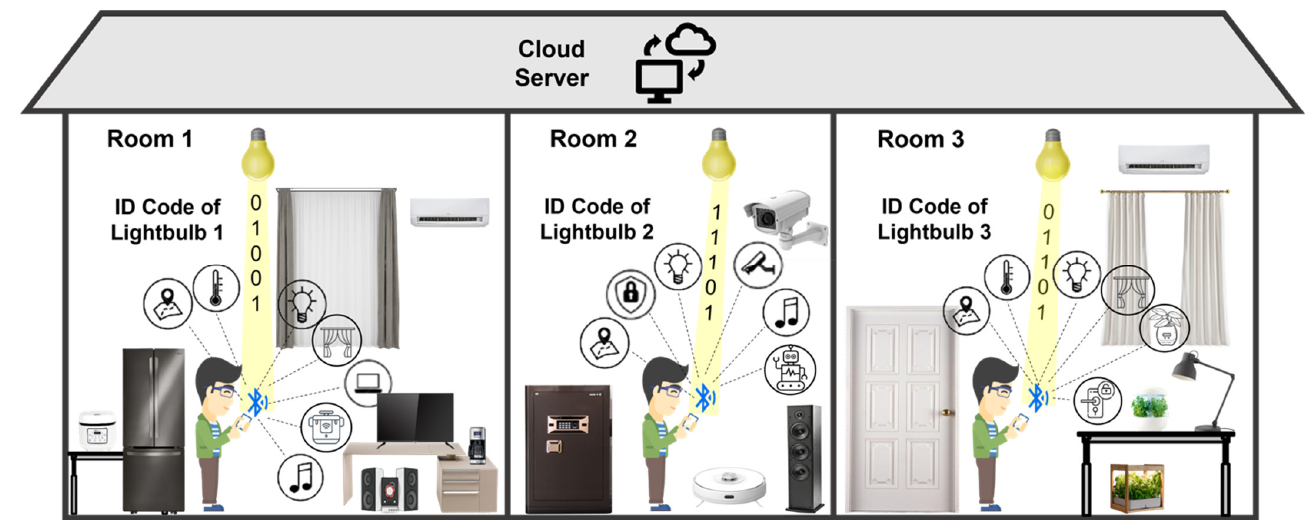
Figure 1. Application scenario of proposed VLC-based smart home control system.